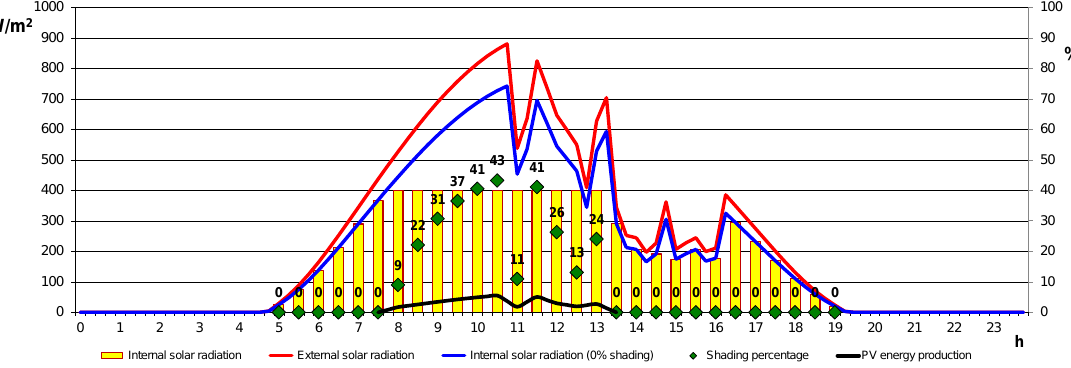
Figure 13. Daily trend of the shading percentage with partly cloudy sky on May 23.